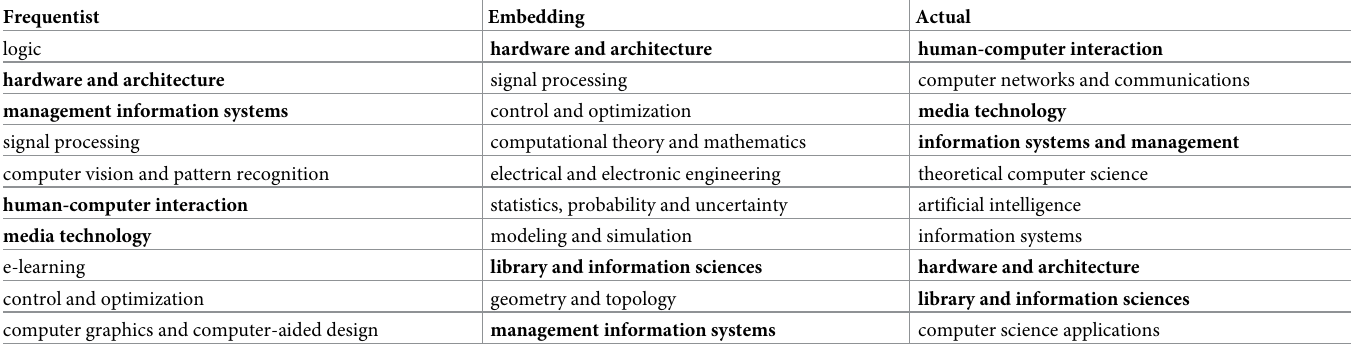
Table 4. Jussara Marques de Almeida. Top 10 predicted areas for inactive to active transition for professor Jussara Marques de Almeida, using both models, and actual top 10 by RCA. Time windows are set as in the first experimental setup.